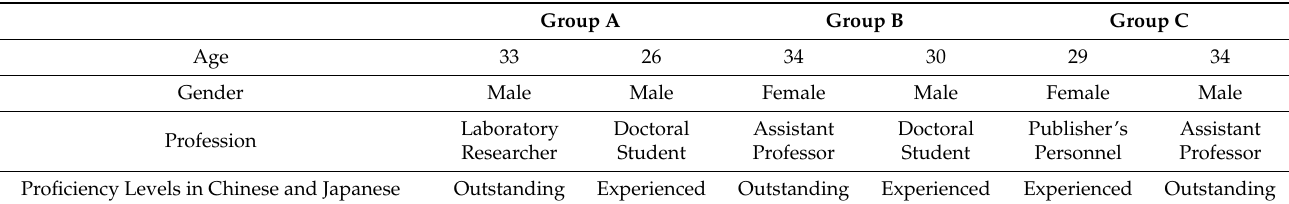
Table 10. Details of the human evaluators involved in the